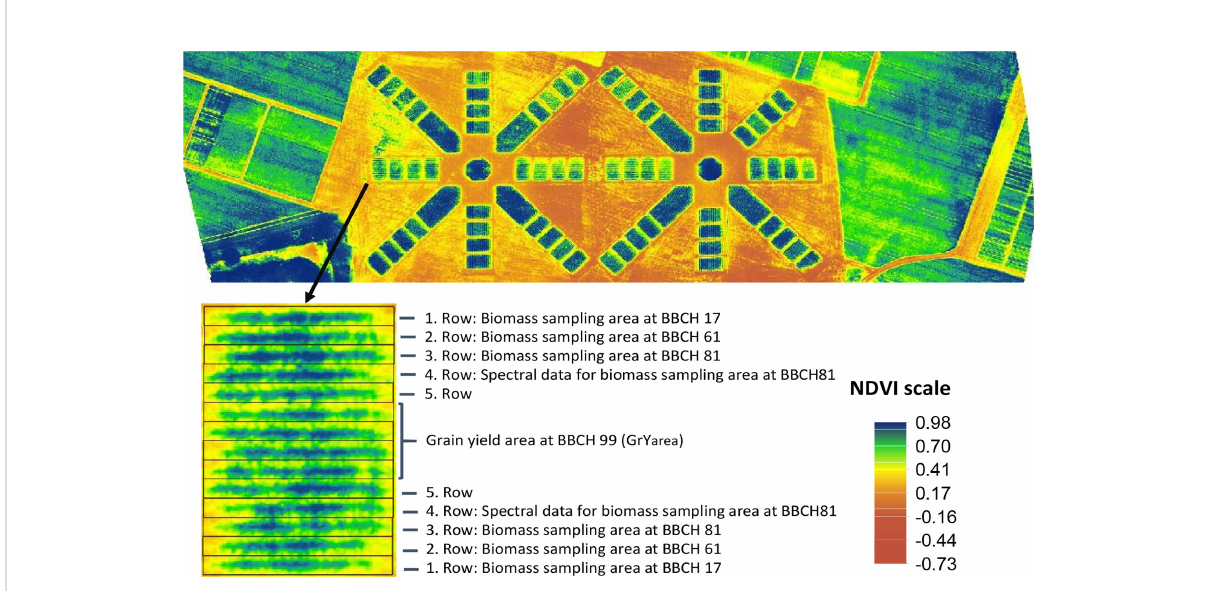
FIGURE 1 NDVI image of maize plots from July 03, 2019, at BBCH 17 at 9:15 am obtained with an eBee drone equipped with a Parrot Sequoia multispectral camera illustrating the plot design of the experiment resembling two stars. The detailed plot view indicates the rows used for the three destructive biomass samplings at BBCH 17, 61, and 81 and the rows used for grain yield harvesting at BBCH